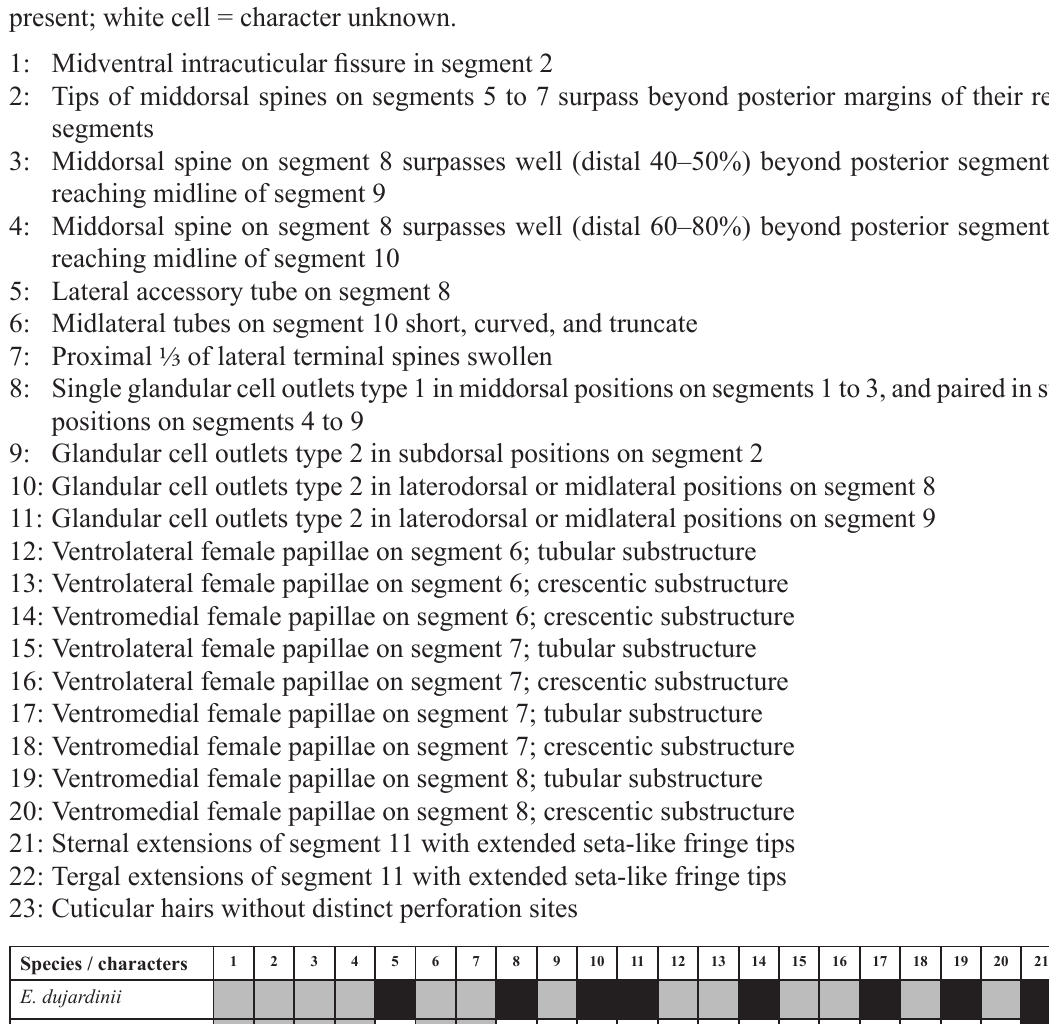
Table 20. Comparative table with shared and differential characters for species of the Echinoderes dujardinii group and similar species (four lower ones) outside the group. Grey cell = absent; black cell = present; white cell = character